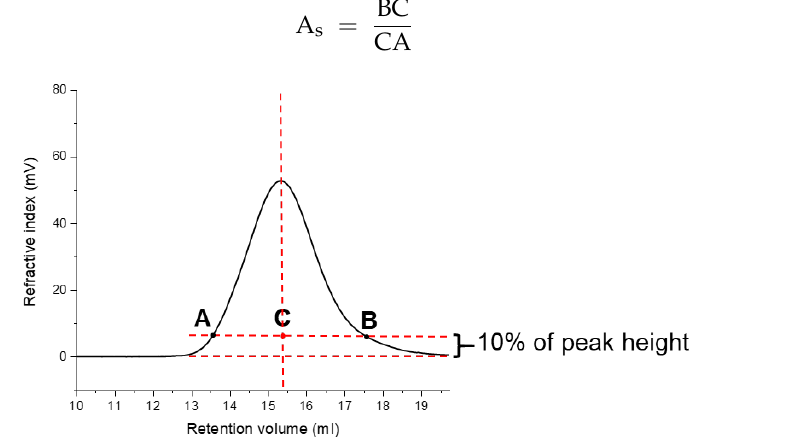
Figure 5. The asymmetry factor (As) measures the peak tailing and is defined as the distance from the center line of the peak to the back slope divided by the distance from the center line of the peak to the front slope, measured at 10% of the maximum peak height.